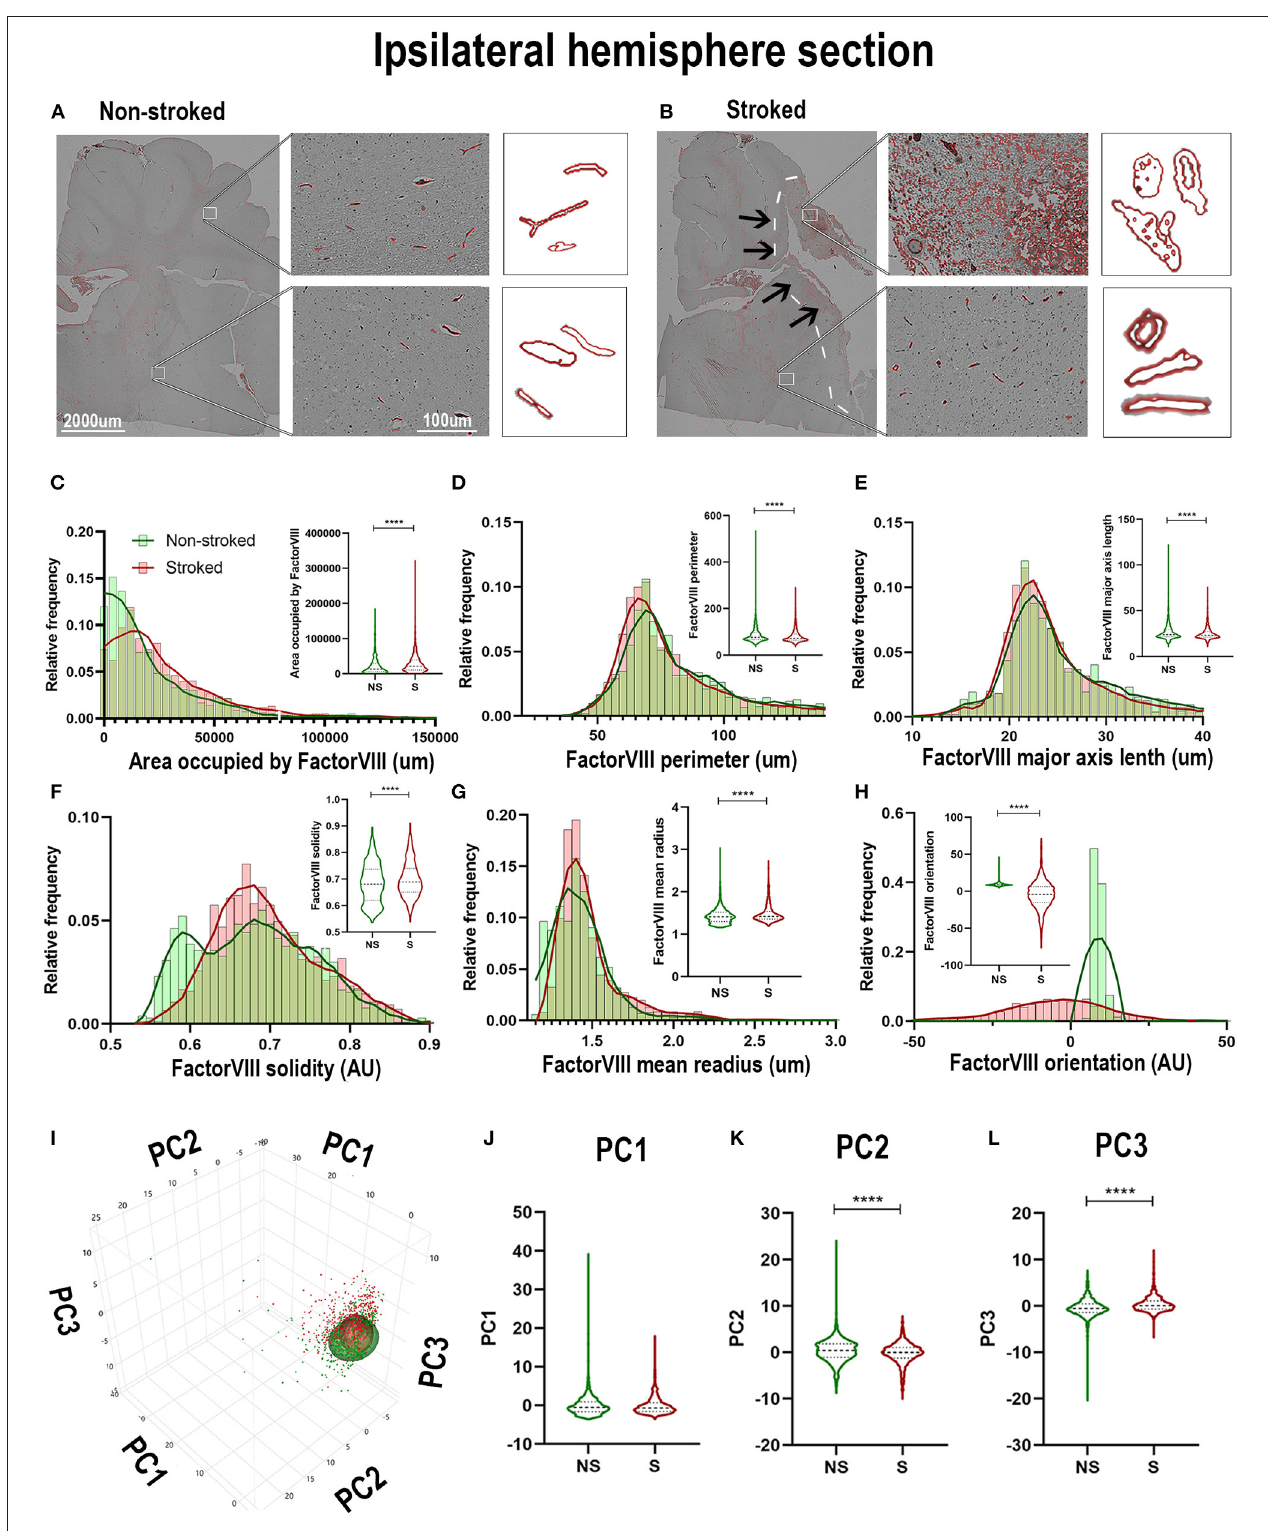
FIGURE 8 | FactorVIII + areas showed altered orientations and decreased size in the ipsilateral hemisphere following stroke. Visual differences in density and location of FactorVIII + areas in ipsilateral hemispheric sections were observed between NS and S animals (A,B) (Barreto et al., 2011; Mittelbrunn et al., 2011). Arrows indicate location of stroke lesion (B) . Significant ( p < 0.0001) increases in area occupied (C) , solidity (F) , and mean radius (G) were observed between ROIs of S ( n = 1,228